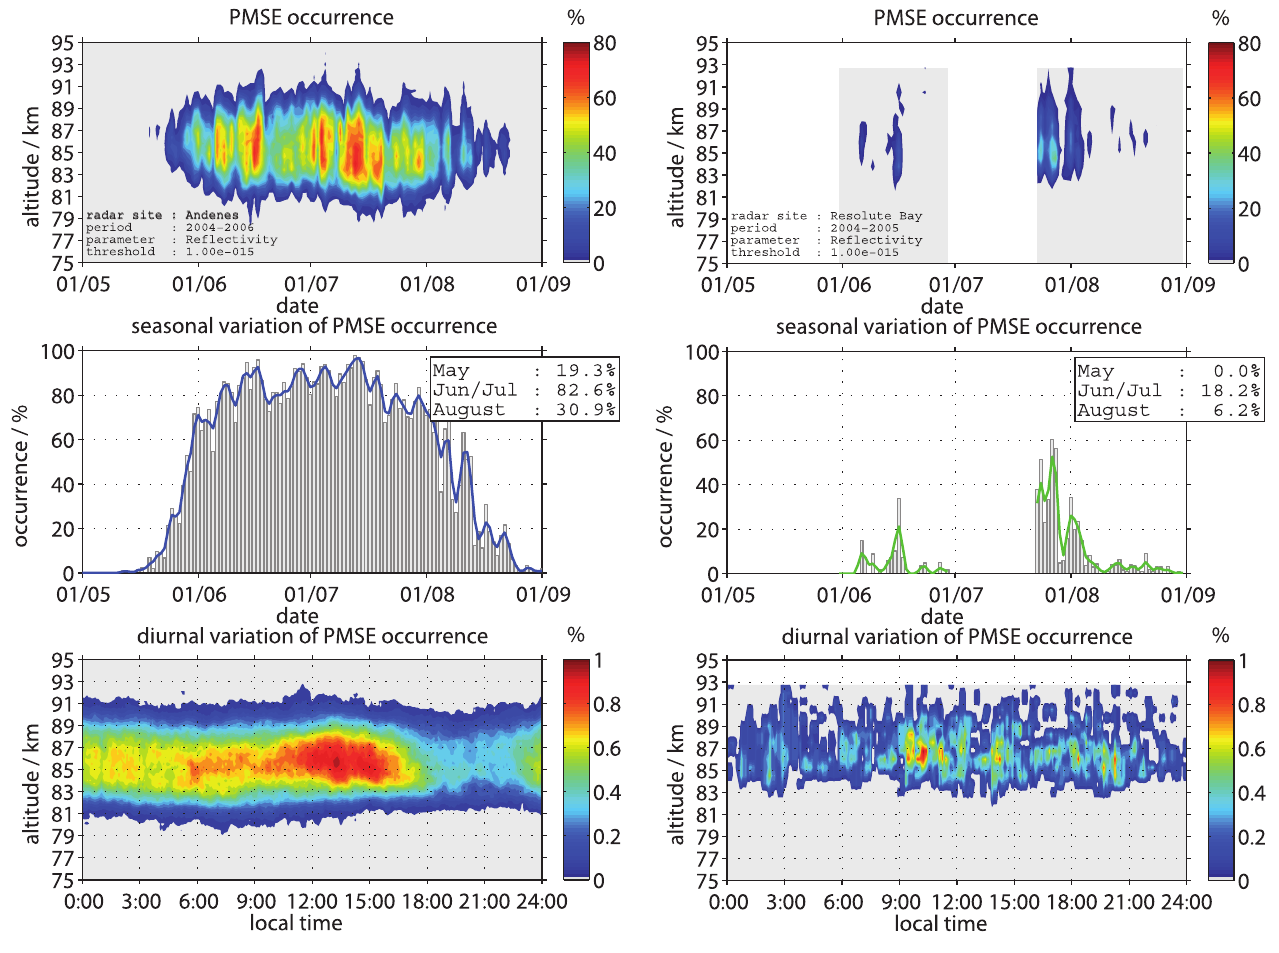
Fig. 13. Seasonal distribution and variation of PMSE occurrence and their diurnal variation above Andenes (2004–2006, left), and Resolute Bay (2004–2005, right). The occurrence rates refer to radar reflectivities above a common threshold of 1 × 10 − 15 m − 1 , and to the number of 5-min averages per day (maximum 288). The seasonal occurrence rate in the middle plots is based on the occurrence of a PMSE event at any height within a 5-min time bin. The solid lines represent a 3-day running mean value (binominal filter). The bottom plots show the daily occurrence rate of PMSE normalized to its